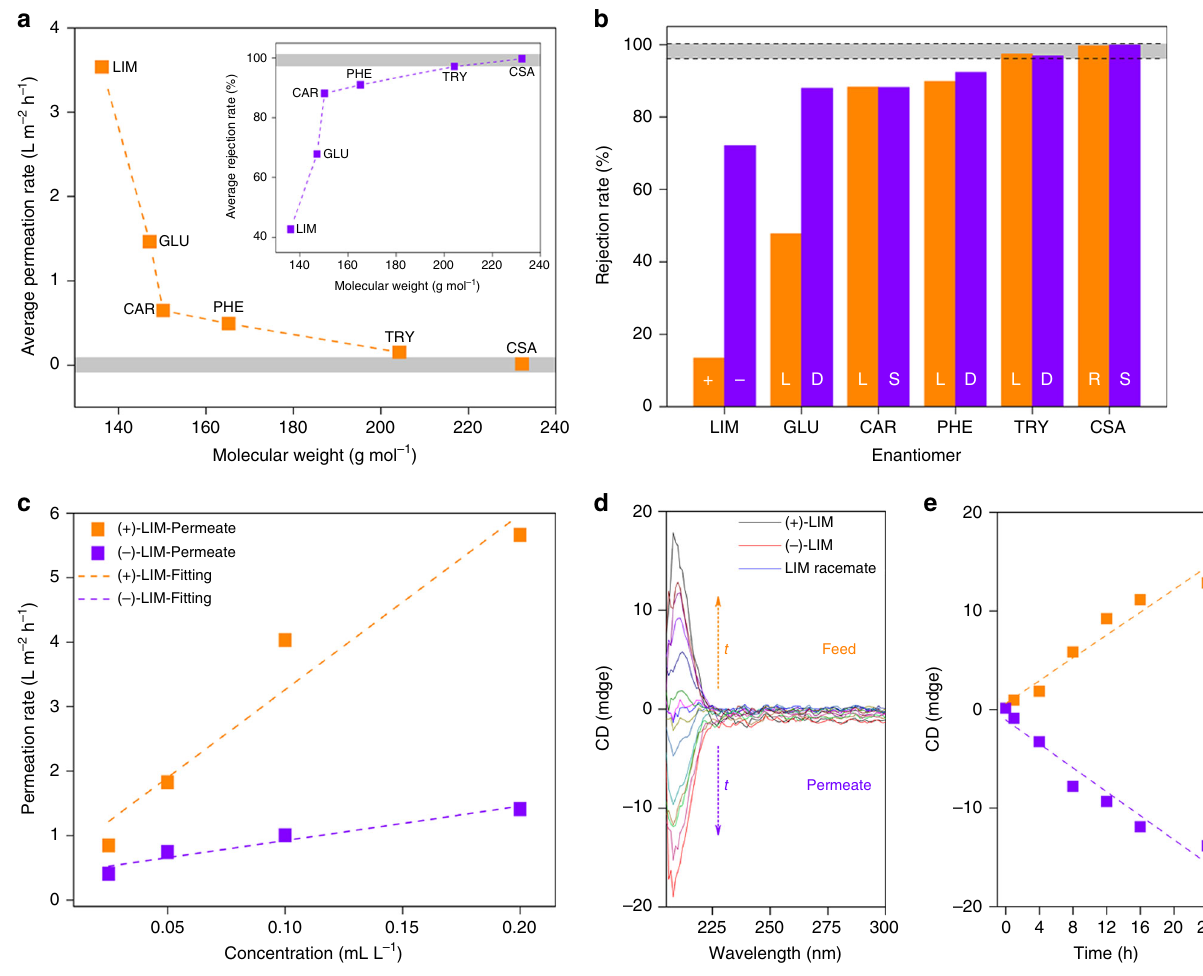
Fig. 4 Enantioselective permeation through GCN-CSA membranes. a , b Average permeation/rejection rates ( a ) and rejection rates ( b ) of various enantiomers with increasing molecular weight (denoted by dotted orange and violet lines, respectively). Average permeation rates and average rejection rates are calculated according to Supplementary Eqs. 1 and 2, respectively. c The permeation rate as a function of initial ( + )/( − )-LIM concentration at feed compartments. Permeation rates are calculated according to Eq. 3. The dotted orange and violet lines are linear fi tting results of permeation rates of ( + )-LIM and ( − )-LIM, respectively. d CD spectra over permeation time at feed (dotted orange line) and permeate (dotted violet line) compartments using LIM racemate. The LIM racemate is a mixture of ( + )-LIM and ( − )-LIM with equal concentration of 0.1 mL/L (in ethanol). e CD signal intensity of solutions at feed and permeate compartments as a function of permeation time. The dotted orange and violet lines denote the linear fi tting results of CD signal intensity of solutions at feed and permeate compartments, respectively. LIM limonene, GLU glutamic acid, CAR carvone, PHE phenylalanine, TRY tryptophan, CSA camphorsulfonic acid. All permeation tests are completed using 600-nm thick